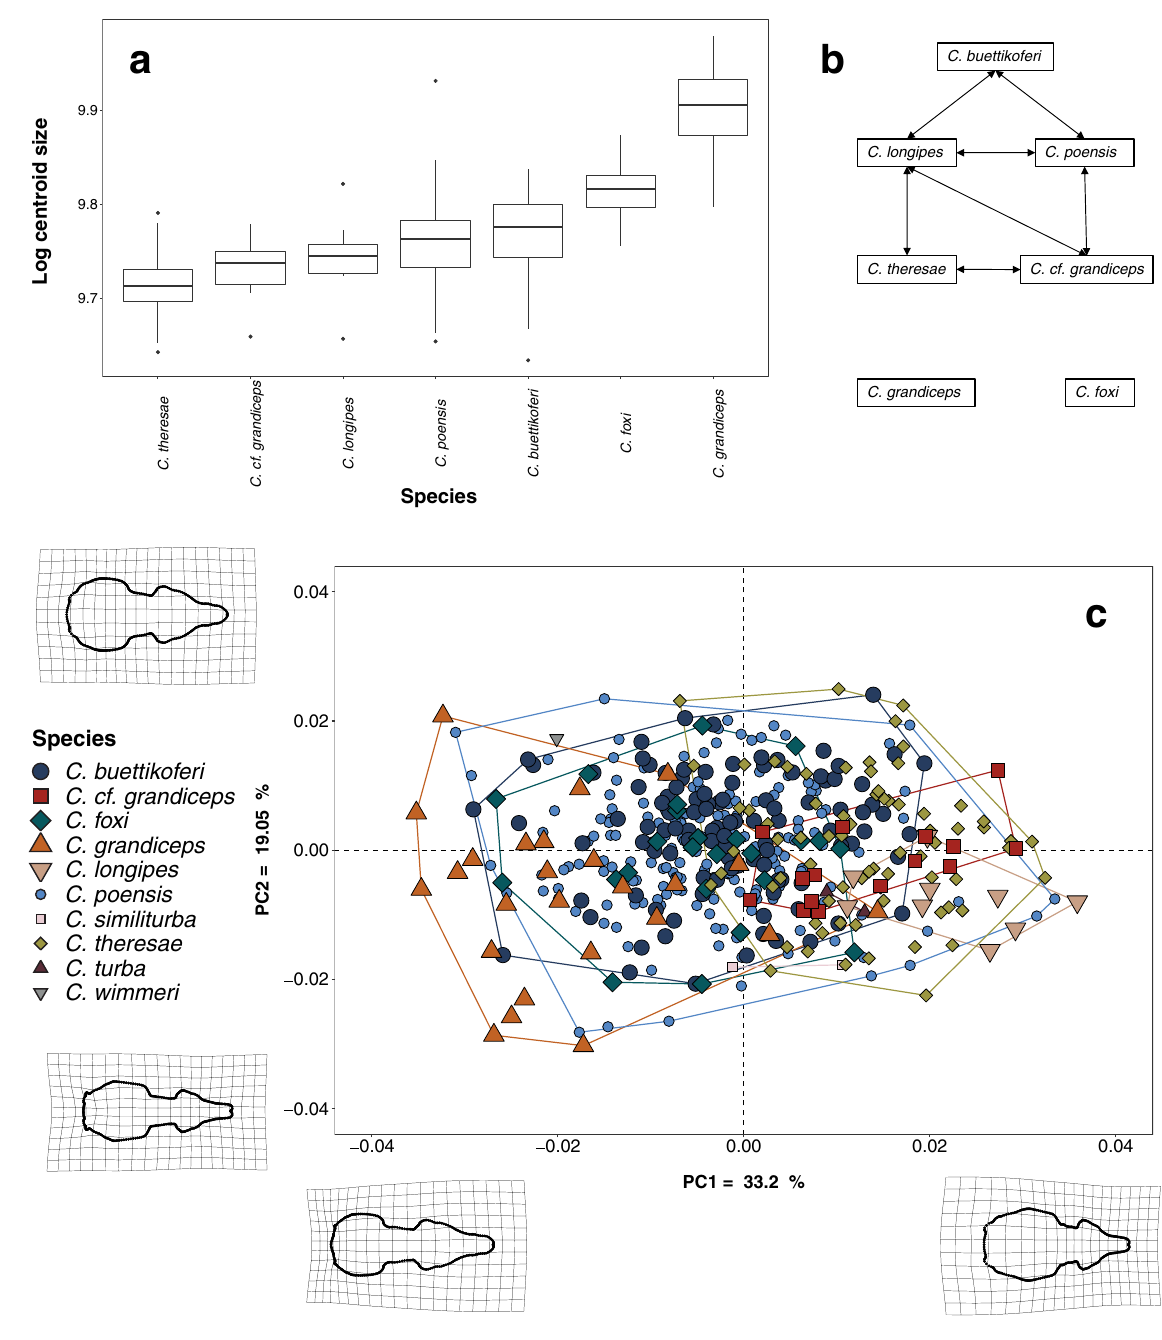
Figure 2. Size and shape variation within the C. poensis species complex. ( a ) Box plot with standardized deviation of log transformed centroid size for species for which N ≥ 9. ( b ) schematic depiction of size similarities. Arrows represent non-significant size differences. ( c ) Scatterplot of the two first PCs and their corresponding shape deformation grids relative to the mean shape, at the negative and positive extremes of the axes. All specimens are depicted, using colors and symbols for species, with minimum convex hull